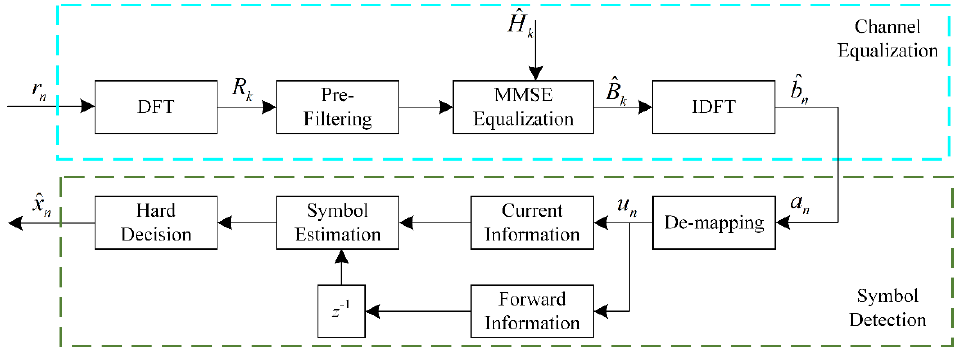
Figure 3. CPM receiver with PF-SCFDE.